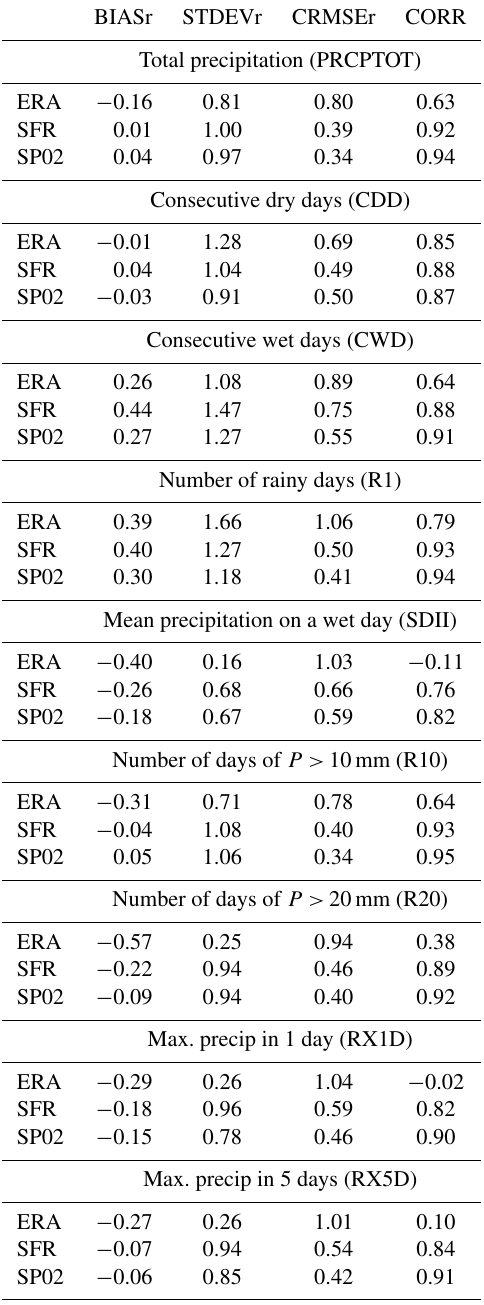
Table 4. A comparison of the performance of ERA-Interim (ERA), SAFRAN (SFR) and Spain02 (SP02) in reproducing the indices of the mean and extreme